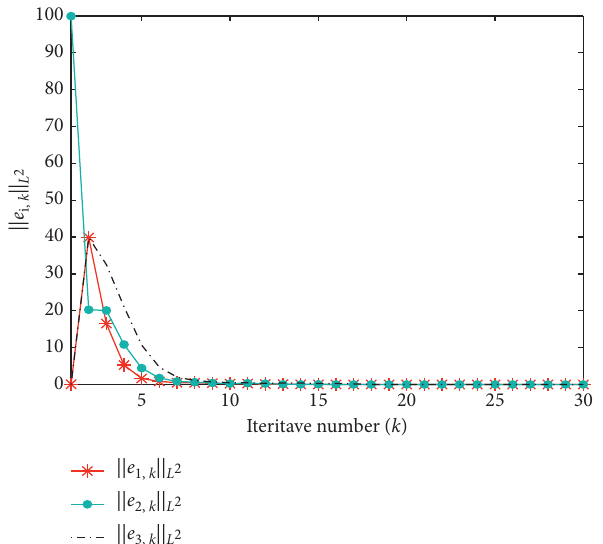
Figure 3: Changes in the consensus error between the three agents and the virtual leader agent in nonlinear hyperbolic partial